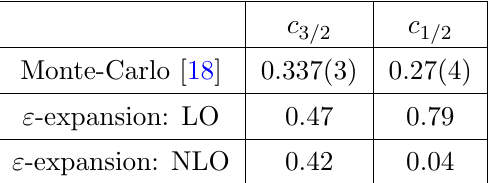
Table 1. Comparison of the Monte-Carlo result in [18] with the " -expansion; we display both the leading order (LO) result as well as the next to leading order